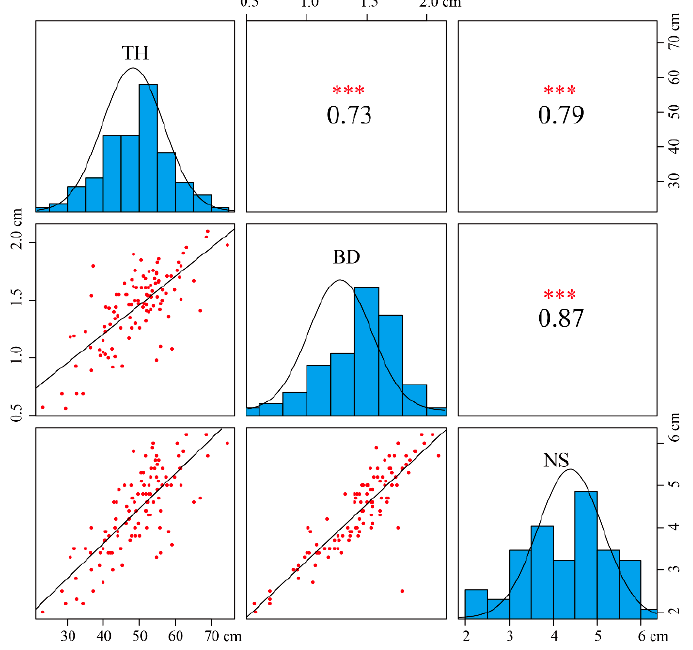
Figure 1. Scatterplots (lower triangle) and correlations (upper triangles) among three growth traits in the F 1 mapping population. Note: TH, BD, and NS represent tree height, basal diameter, and node spacing, respectively. *** indicates extreme significance.